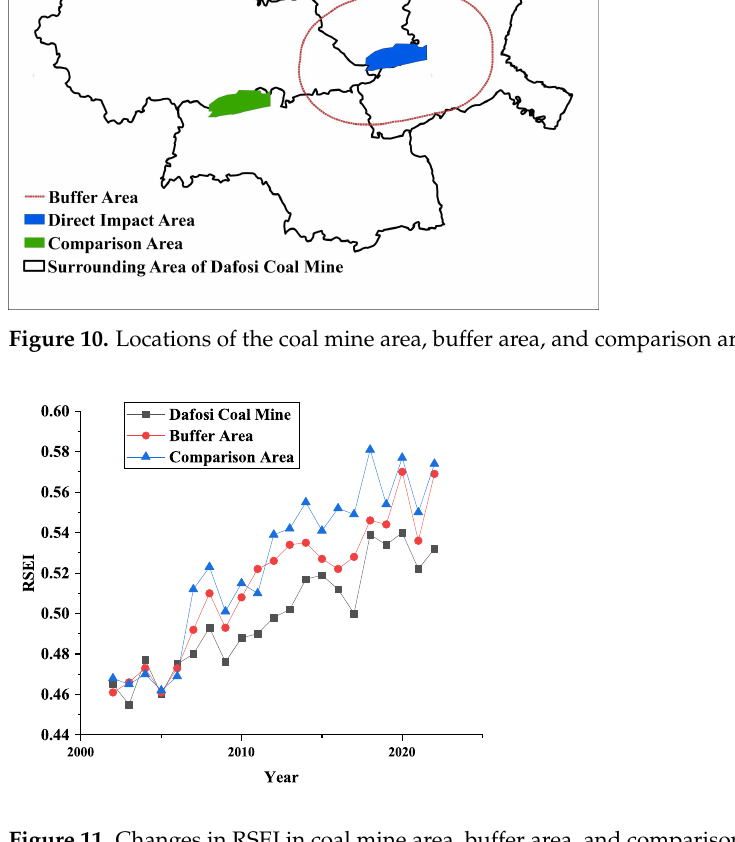
Figure 11. Changes in RSEI in coal mine area, buffer area, and comparison area from 2005 to 2022.